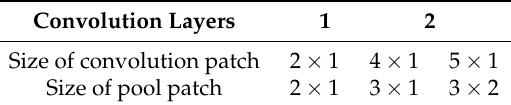
Table 1. Proposed and tested number of convolution layers, size of convolution patches and size of pool